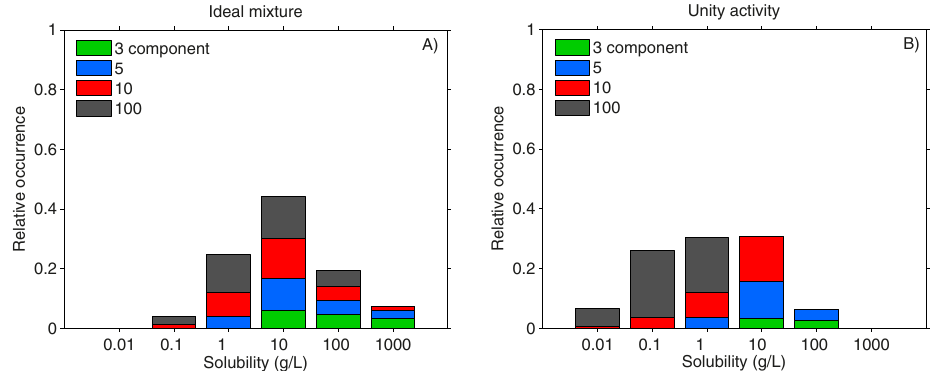
Figure 9. The distributions of the c t values (i.e., the 50% partitioning point; see Eqs. 24 and 25) at the point of activation for all the considered mixtures (Table 2) and activation points, and the two assumptions about the organic-phase activity. (a) The ideal organic mixture. (b) The unity activity assumption.